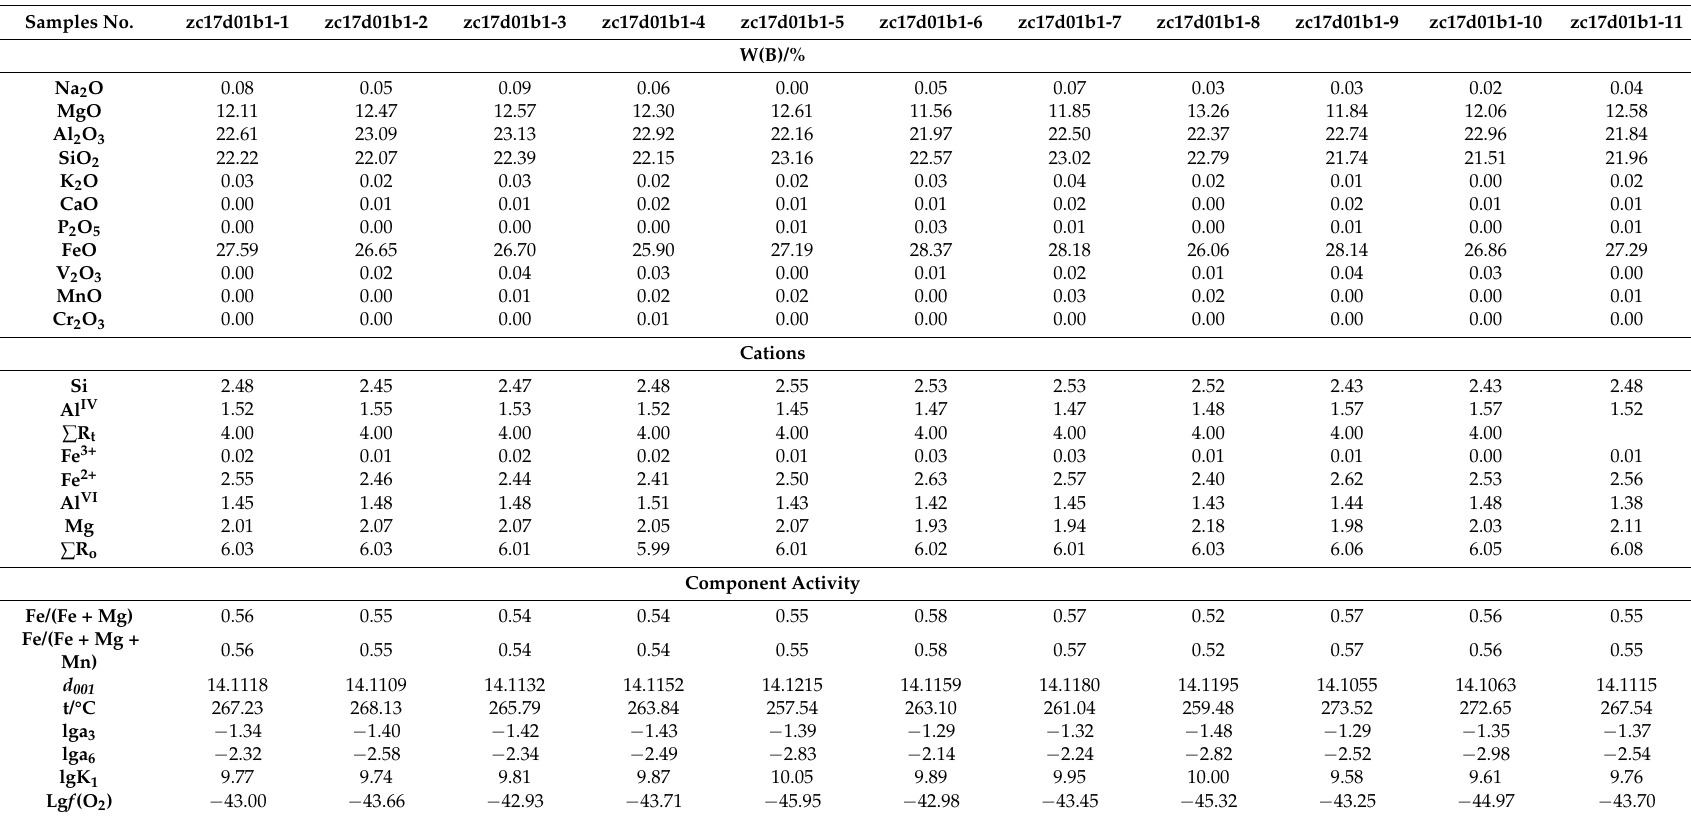
Table 2. Chemical compositions of chlorite in pressure shadows at the Zhengchong gold deposit. Samples